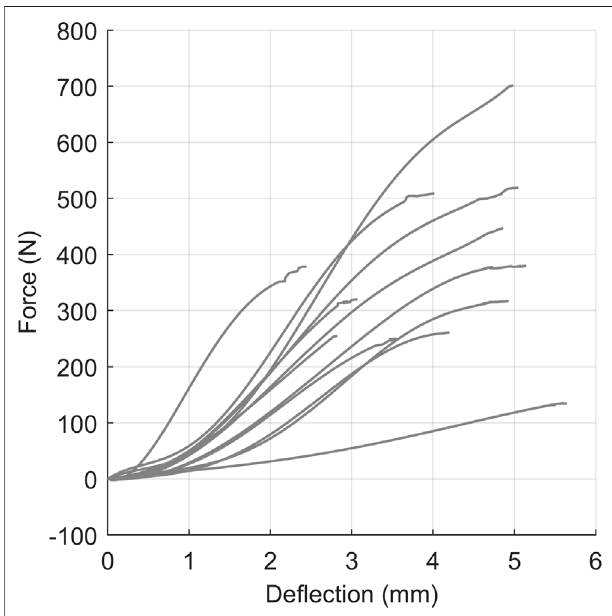
FIGURE6| Thequasi-staticforce-displacementresponseof12anterior longitudinal ligament specimens (Mattucci et al., 2012).